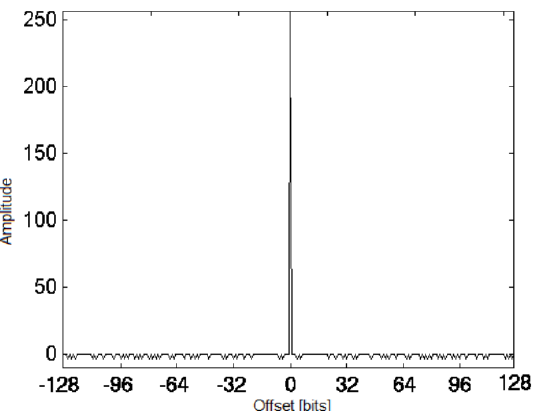
Figure 3. Typical autocorrelation function of a B-TCH polynomial with n = 256, [24].